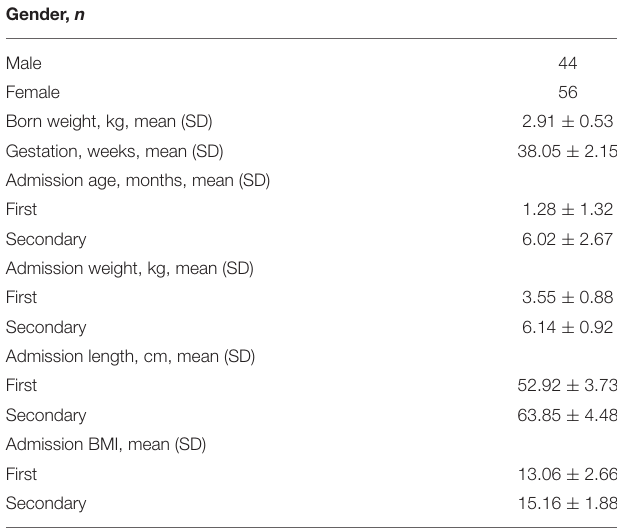
TABLE 1 | Baseline characteristics ( n =